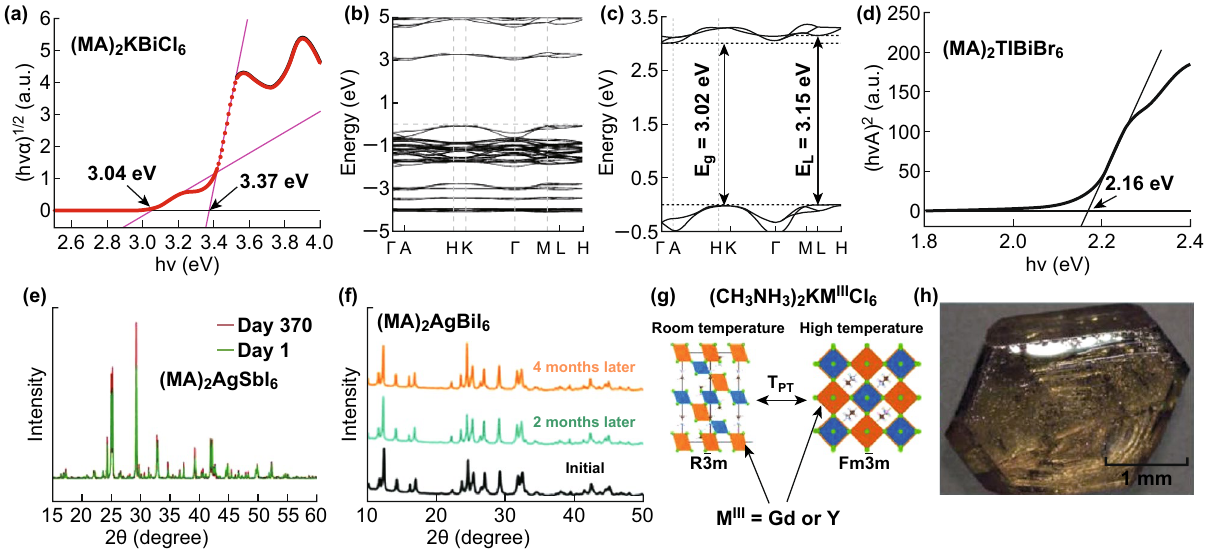
Fig. 3 a Tauc plot (assumed indirect bandgap), b‑c calculated band structure of (MA) 2 KBiCl 6 and the enlarged view of the band structure near the bandgap. Reproduced with permission from Ref. [38]. d Tauc plot (assumed direct bandgap) of (MA) 2 TlBiBr 6 . Reproduced with permission from Ref. [82]. e XRD patterns of fresh (MA) 2 AgSbI 6 compared to (MA) 2 AgSbI 6 after 370 days of exposure to air. Reproduced with permission from Ref. [84]. f Air stability of (MA) 2 AgBiI 6 . Reproduced with permission from Ref. [85]. g Schematic illustration of rhombohedral-to-cubic phase transition on high-temperature heating for (MA) 2 KGdCl 6 and (MA) 2 KYCl 6 . Reproduced with permission from Ref [86]. h Photograph of a